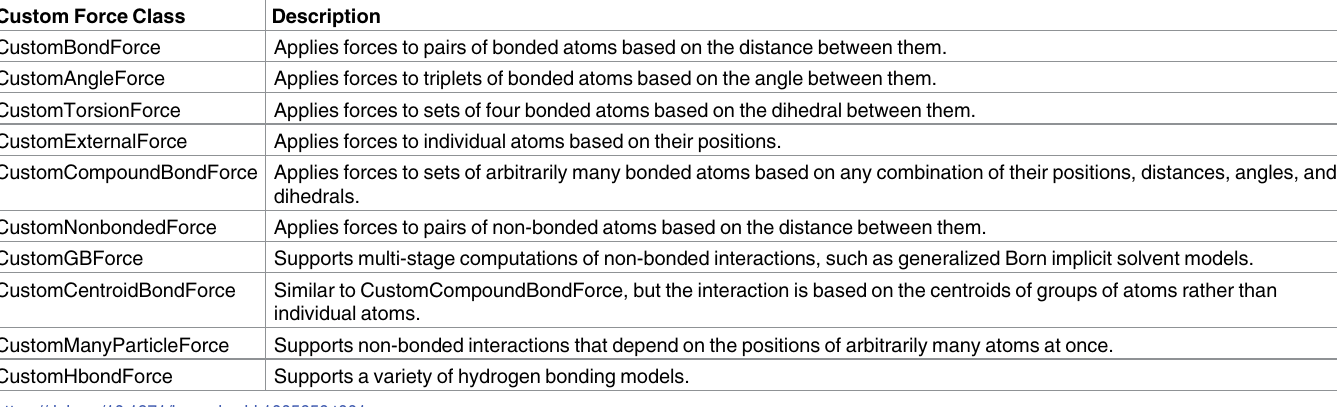
Table 1. Custom forces supported by OpenMM